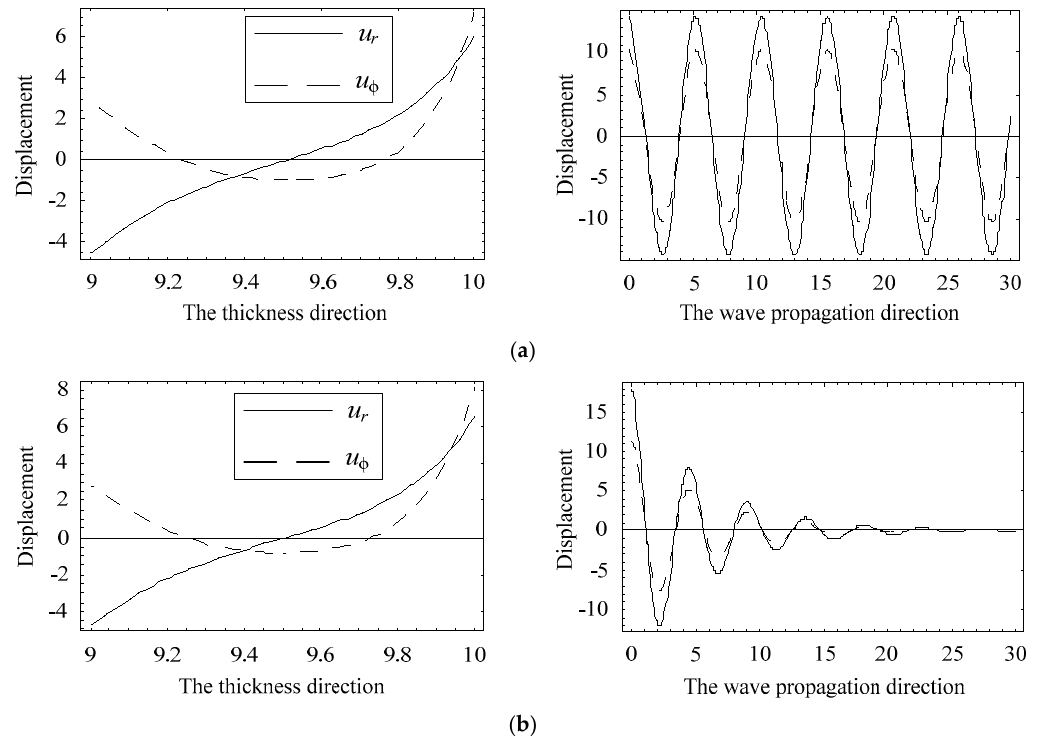
Figure 14. Distributions of the displacement: ( a ) Ω = 1.21815, Ψ = 0.19264, ( b ) Ω = 1.21019, Ψ = 0.21937–0.02803i.